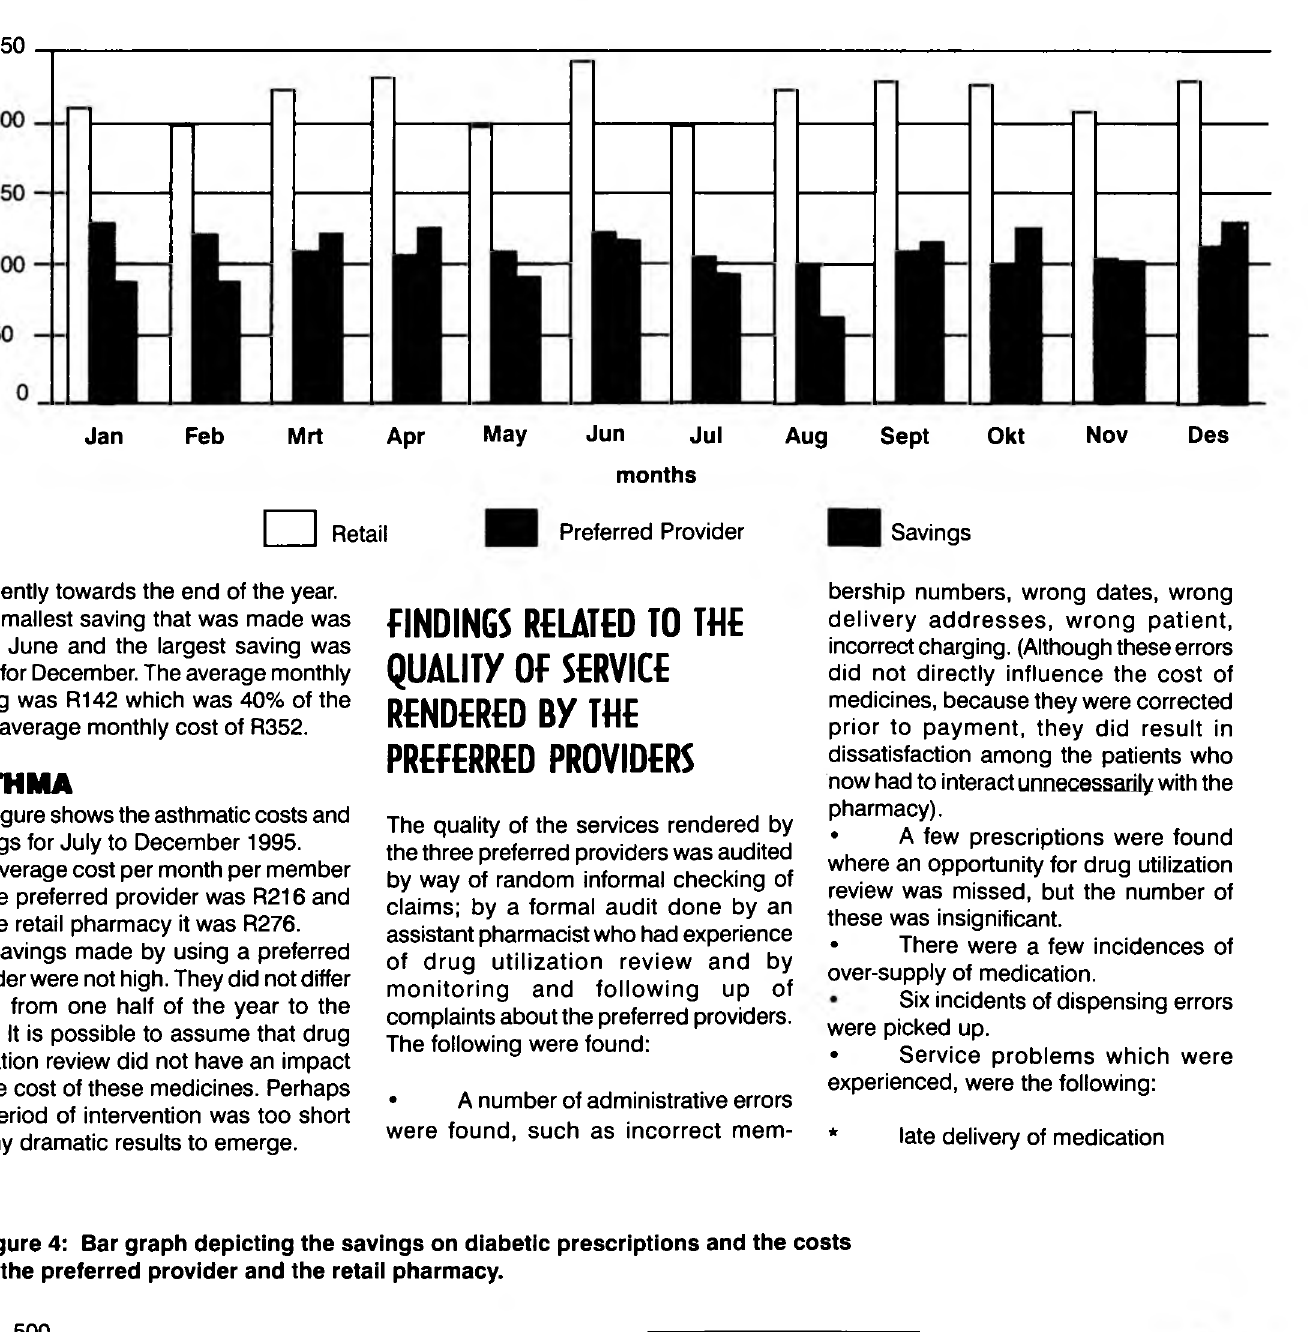
Figure 4: Bar graph depicting the savings on diabetic prescriptions and the costs of the preferred provider and the retail